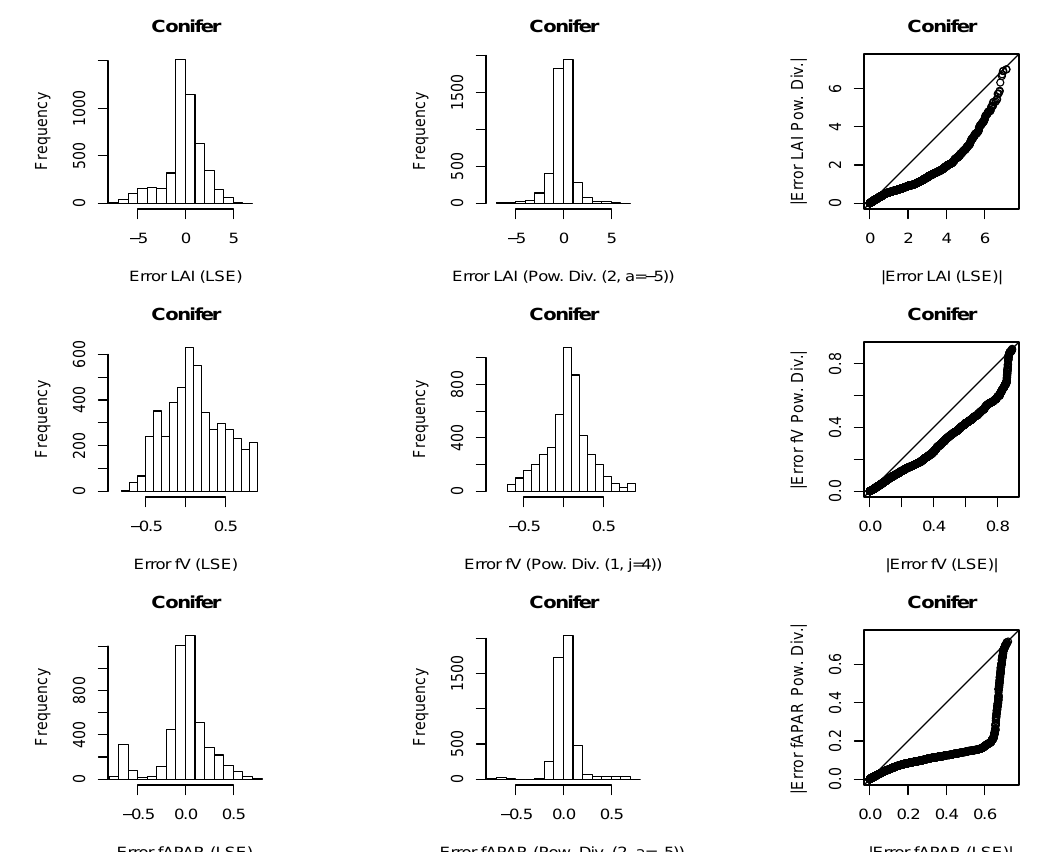
Figure 2. Comparison of residual errors resulting from the application of two different distance measures used to estimate biophysical parameters for needleleaf canopies with a look-up table (LUT). Biophysical parameters, including leaf area index, LAI , fraction of photosynthetically active radiation absorbed by the canopy, f , and vegetation cover APAR fraction, f , are estimated from simulated ground reflectance values. The rows from V top to bottom show the comparison of residual errors in estimating LAI with the least squares estimate (LSE) and power Equation (13) with power 2 and α = − 5 (top row), of residual errors in f with LSE and the power divergence Equation (12) with power V 1 and j = 4 (centre row), and of residual errors in f with LSE and the power APAR Equation (13) with power 2 and α = − 5 (bottom row). The columns from left to right show frequency distributions of residual errors using LSE as a cost function (left column) and the residual errors using either a power equation for LAI and f or a power divergence APAR Equation( (12)) with power 1 and j = 4 for f (centre column). The right column shows V the quantile–quantile plots comparing the frequency distributions of the left and centre columns expressed as absolute errors. The errors in biophysical parameters associated with the alternative cost functions are smaller and better behaved (more symmetrical and smaller